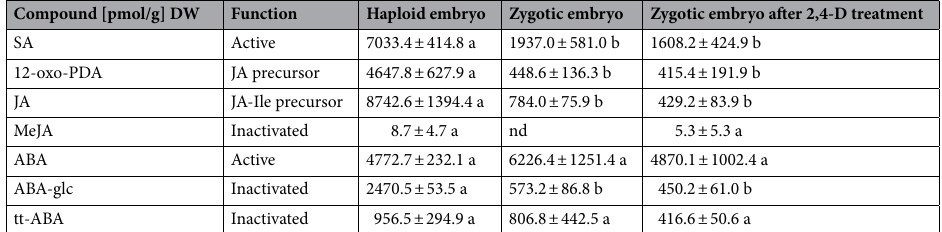
Table 3. Stress-related hormones in cv. ‘Krezus’ embryos. Values are means of three replicates ± standard error. Means indicated by the same letter do not significantly differ at P < 0.05 according to one-way ANOVA and post hoc Duncan’s